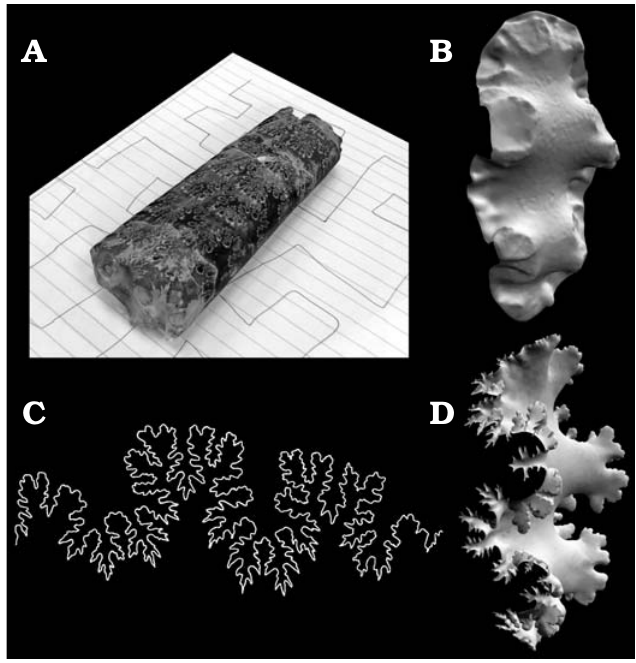
Fig. 1. Three-dimensional reconstruction of a fragmentary baculite Bacu lites compressus Say, 1820 (WSU-1400) from the late Campanian Pierre Shale of Meade County, South Dakota. A . Model of a fragmentary speci men gene- rated by photogrammetry with the software (3DF Zephyr). B . Broken septum isolated from the photogrammetry model. C . Suture pattern. D . Complete septum created by reconstructing the higher-order frilling with the suture pattern as a template.